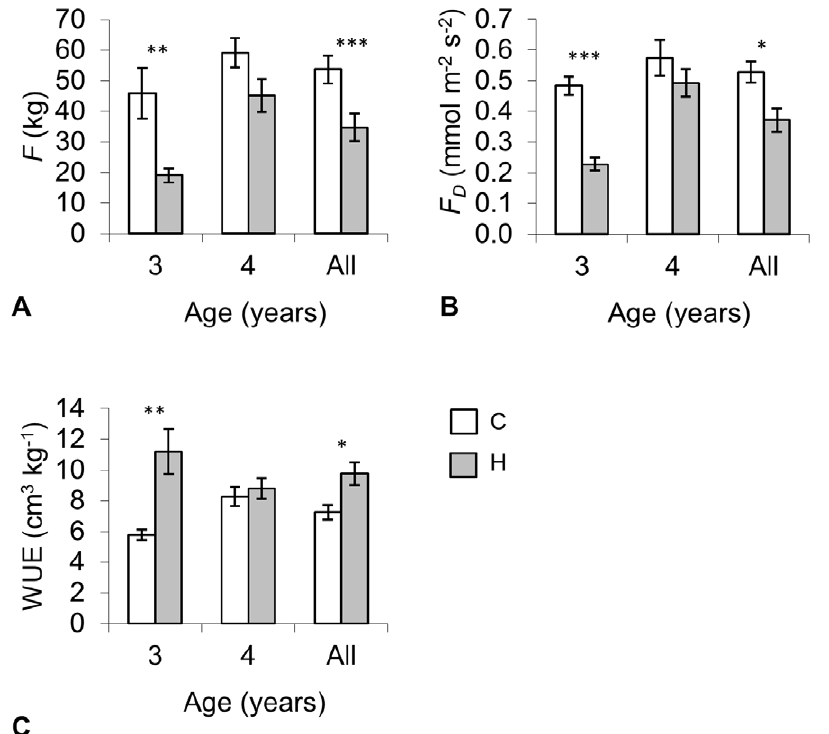
Figure 6. Comparison of physiological traits: a) F – total sap flow, b) F D – sap flux density, c) WUE – water-use efficiency of hybrid aspens at the ages of 3 and 4 years in control (C) and humidified (H) plots ( t -test) and summary effect of the treatment over two years (model), whiskers denote ± standard error.